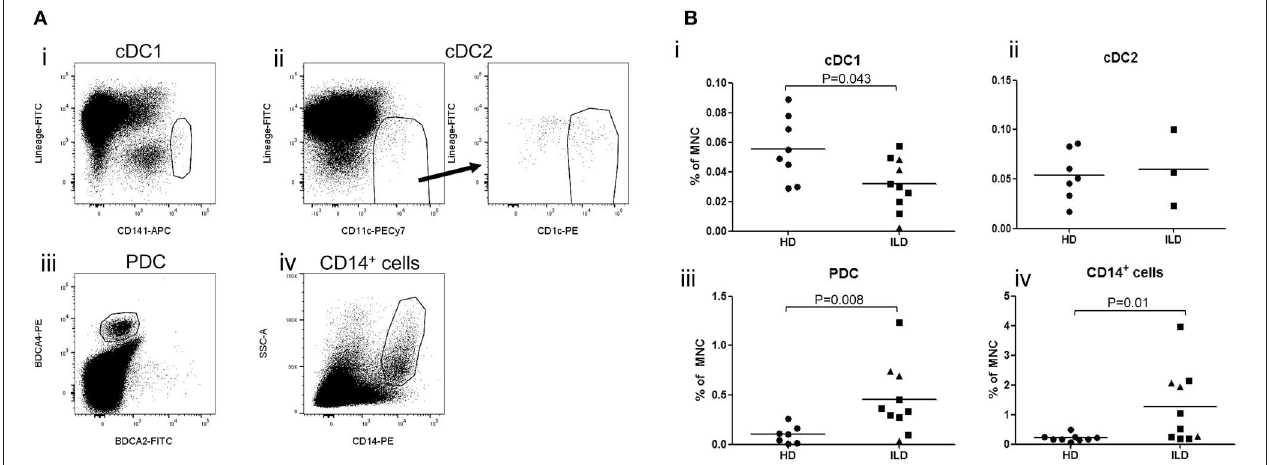
FIGURE 6 | (A) Relative numbers of APC subsets in liver lymph nodes of patients with inflammatory liver diseases. Flowcytometric analysis of cDC1 and cDC2 in single cell suspension of a LN attached to an explanted liver of a PSC patients. Within viable CD45 + cells, CD141 hi cDC1 and CD11c + CD1c + cDC2 were gated. (B) The percentages of cDC1, cDC2, PDC, and CD14 + cells were determined within CD45 + MNC in hepatic lymph nodes derived from healthy donors (HD; n = 8) and patients with inflammatory liver disease (ILD; n = 10 for cDC1 and n = 3 for cDC2). Patients with primary sclerosing cholangitis are depicted as squares and patients with auto-immune hepatitis as triangles. Lines indicate